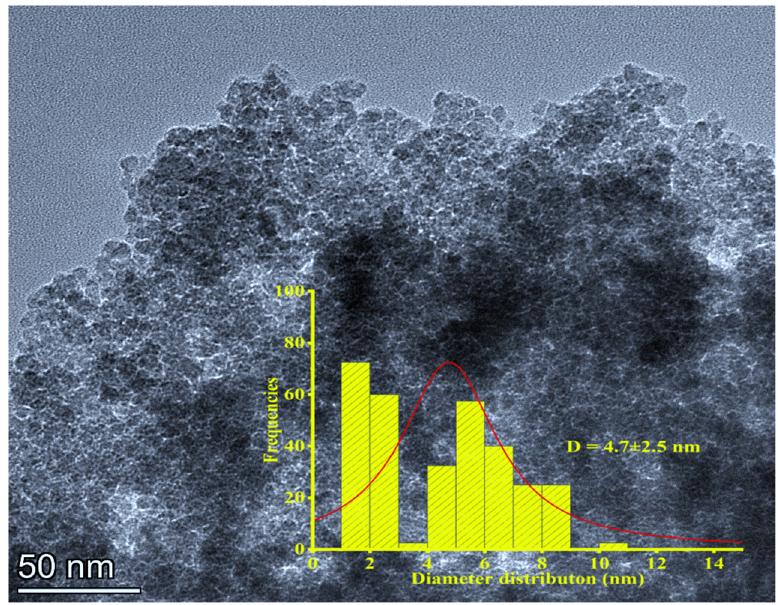
Figure 2. Transmission electron microscopy (TEM) of the green synthesized Fe x O y -NPs using aqueous extract of Phoenix Dactylifera L.